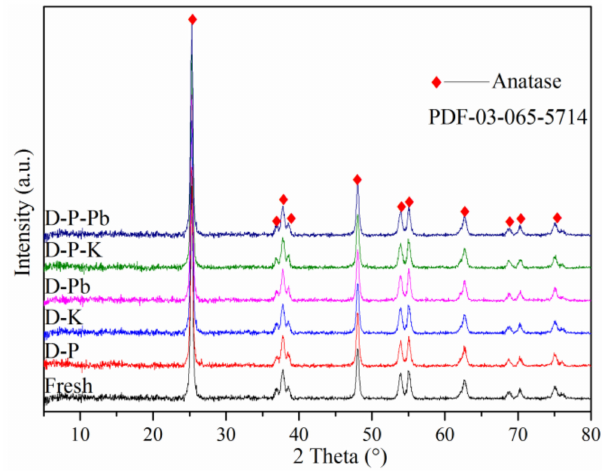
Figure 2. XRD patterns of fresh and poisoned